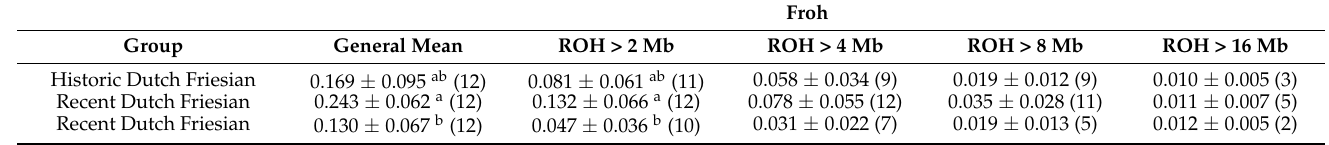
Table 3. Mean and standard deviation of inbreeding coefficients (Froh) calculated from runs of homozygosity (ROH) with minimum length of 2 (ROH > 2), 4 (ROH > 4), 8 (ROH > 8), and 16 (ROH > 16) Mb for the three groups. Between brackets is the number of animals in the classes.